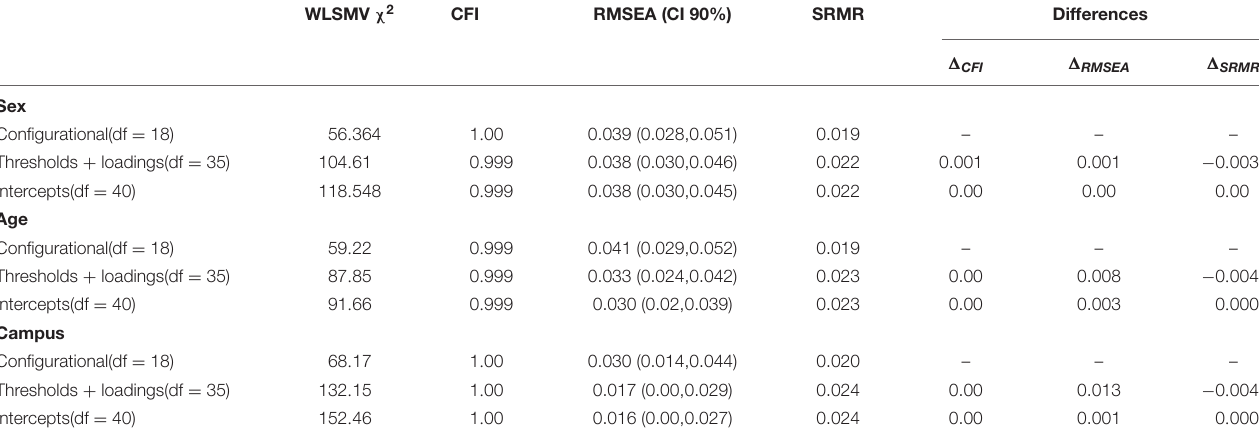
TABLE 5 | Measurement invariance results for the SNA-6